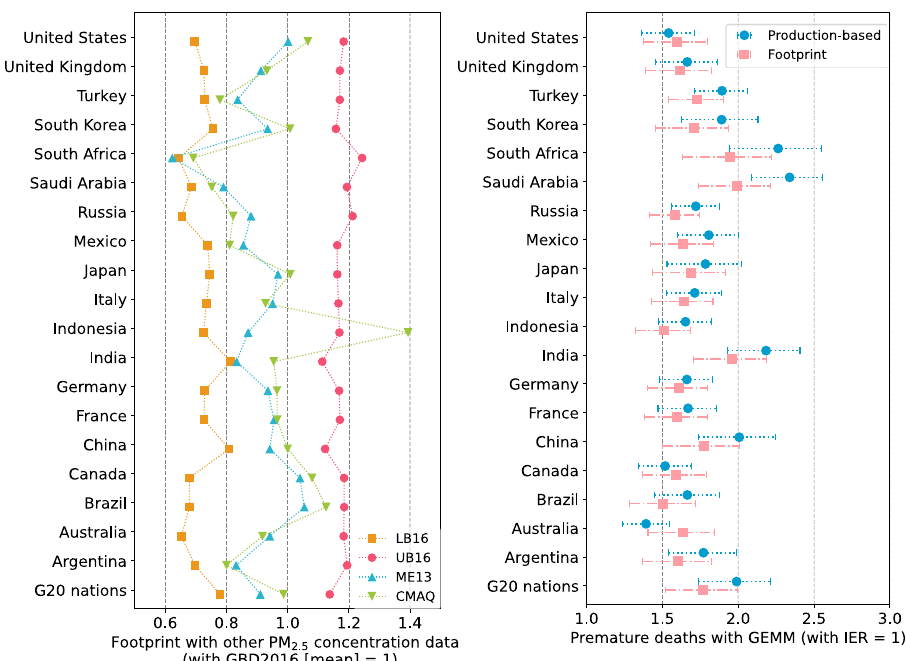
Fig. 7 (Left) Change in premature deaths footprint when the other PM 2.5 concentration data (LB16, UB16, ME13, CMAQ) are used for grid-square concentrations to estimate total premature deaths in each square, relative to 1 for premature deaths with the IER (Integrated Exposure-Response) model (50% value) and PM 2.5 concentration (mean) in GBD2016 (Global Burden of Disease 2016). (Right) Change in number of premature deaths (age 25 years and older) for footprint and production-based emissions when GEMM (Global Exposure Mortality Model) is used for relative risk calculation, relative to 1 for premature deaths with IER model (50% value). Error bars indicate 95% con fi dence intervals (CI). LB16 and UB16 are the cases with the lower and upper bound concentration in 95% CI of GBD2016, respectively. ME13 is the case with GBD2013 concentration (mean) in 2010 and CMAQ is the case with concentration calculated by the CMAQ (Community Multiscale Air Quality) modelling system. The cases of IER with upper and lower bounds of the 95% CI are shown in Supplementary Fig. 12 in the Supporting